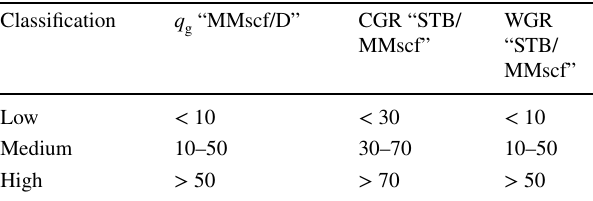
Table 1 Criteria used for the classification for gas wells